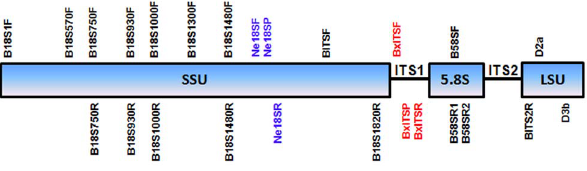
Figure 1. Primer and probe locations for PCR amplification, sequencing and real-time PCR of ribosomal